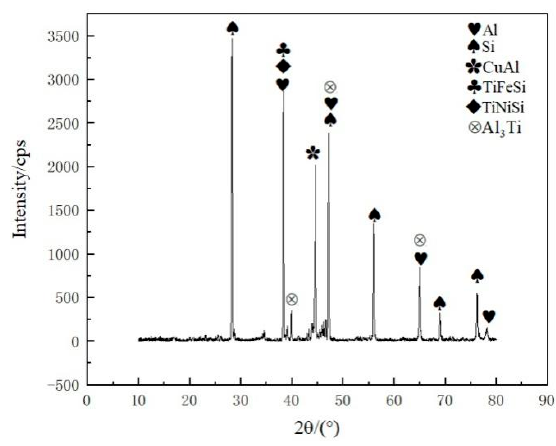
Figure 9. XRD analysis of vacuum brazing joint made using Al-7.5Si-23.0Cu-2.0Ni-1.0Ti as filler metal at brazing temperature of 580 °C and brazing time of 30 min.